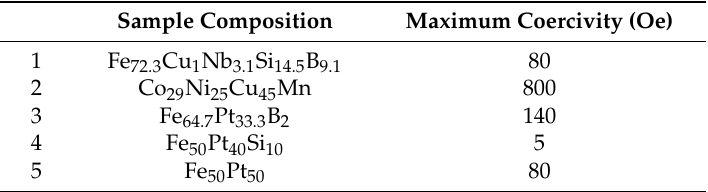
Table 4. Composition and maximum coercivity of semi-hard glass-coated microwires. Sample Composition